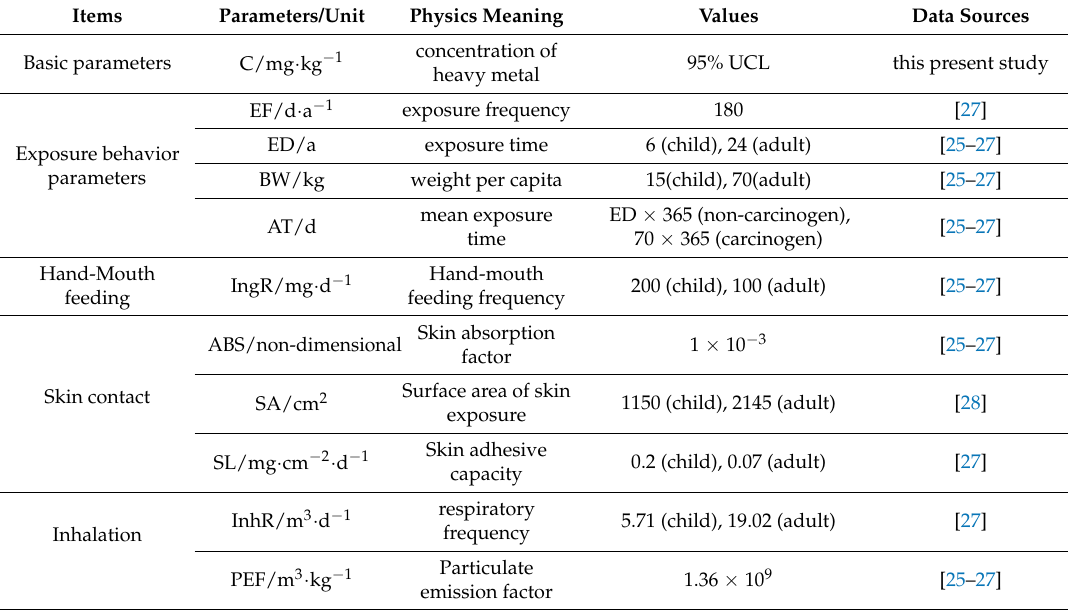
Table 2. Calculation parameter values of the daily average exposure of heavy